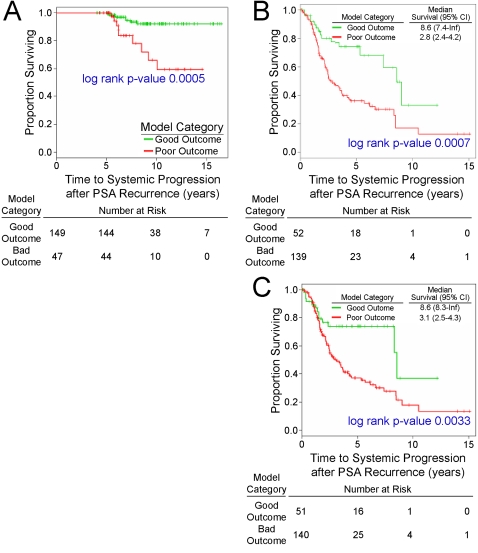
Systemic progression-free and overall prostate cancer-specific survival in the PSA control and SYS case groups.A) Systemic progression-free survival for the patients classified in the poor outcome category and for those in the good outcome category in the PSA control group–17 gene/probe model. B) Prostate cancer-specific overall survival for the patients classified in the poor outcome category and for those in the good outcome category in the SYS case group–17 gene/probe model. C) Prostate cancer-specific overall survival for patients classified in the poor outcome category and for those in the good outcome category in the SYS case group-Lapointe et al. 2004 recurrence model.